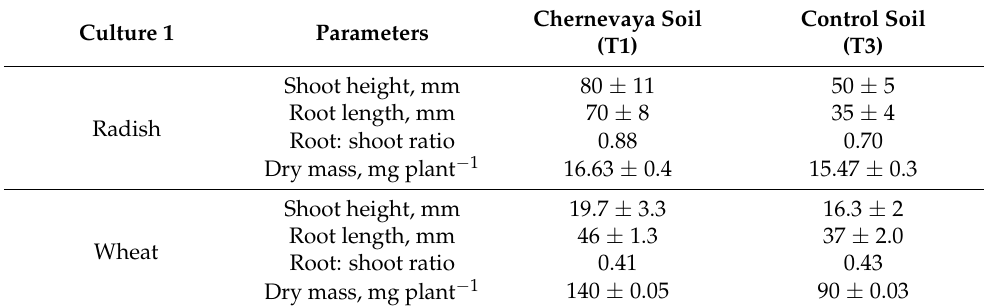
Table 2. Measurements of the physiological parameters of radish and wheat plants grown in pots with control and Chernevaya taiga soils.